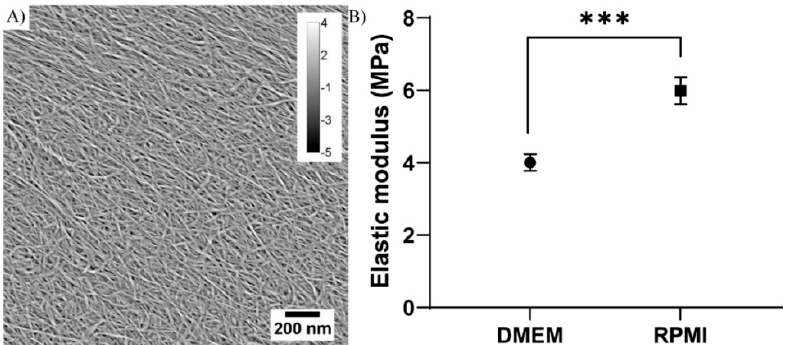
Figure 1. Structural morphology and stiffness of TEMPOCNF. ( A ) AFM nanoscale image of nanofibrils with diameter <20 nm. The scale bar (lower right) and calibration (upper right) indicate the scales in nanometers, in the x, y and z-directions, respectively. ( B ) Elastic modulus of analysis on TEMPO-CNF in DMEM and RPMI medium, respectively. The dots represent average elastic modulus and error bars represent standard error of the mean ( n = 42–43); unpaired t -test. *** p -value < 0.001.